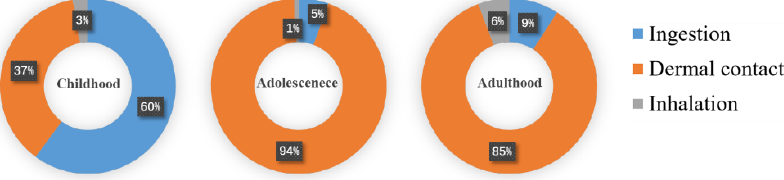
Figure 7. Cumulative probability of ILCRs in different exposure pathways for childhood, adolescence, and adulthood.